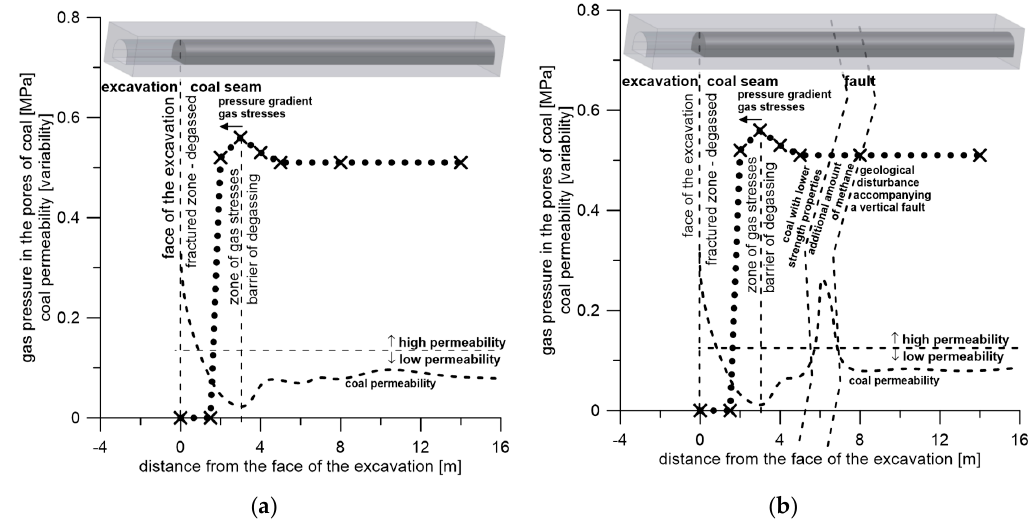
Figure 1. The pressure of gas in the coal pores as a function of the distance from the excavation face—degassed zone, gas stresses zone, and coal permeability—the excavation free form geological disturbances ( a ) and the excavation with geological disturbances ( b ).